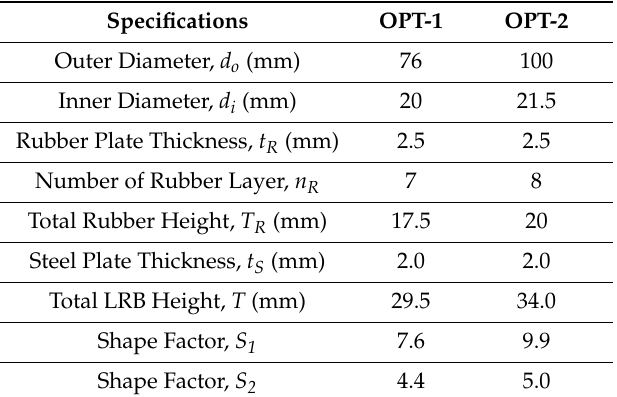
Table 2. Dimensional specifications of laminated rubber bearing (LRB) and shape factors.